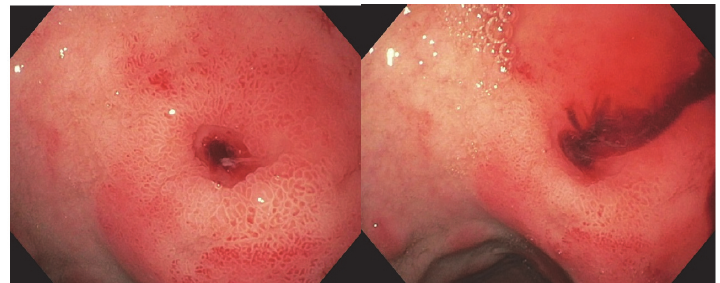
Figure 1: Dieulafoy lesion with active bleeding.